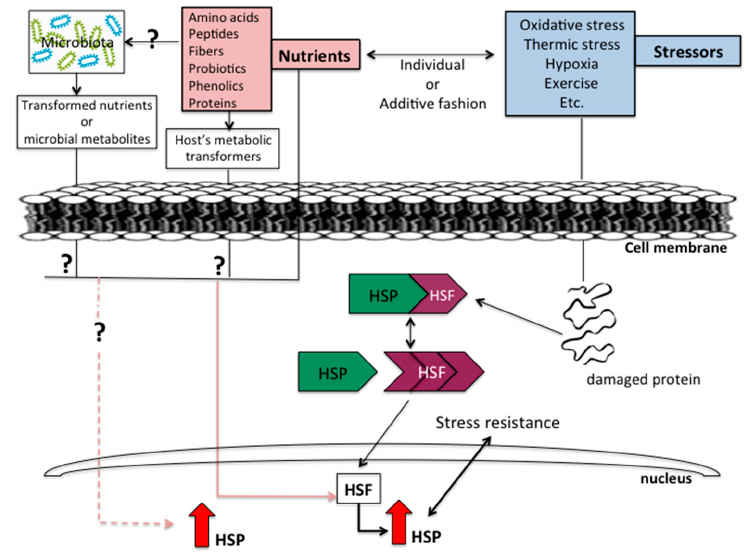
Figure 1. Schematic representation of the role of the classical heat shock-response inducers, now adding nutrients and bioactives. The two kinds of inducers could act individually or in an additive fashion. Explanation: (left side) an ingested nutrient or bioactive could enter directly both the cytoplasm and nucleus as such or be transformed by the microbiota (extracellularly to the host) or by the host’s (intracellularly) own metabolism. On the right-hand side, the classical scheme showing the induction of HSPs that requires the dissociation of the HSP-HSF complex and the participation of HSF in the production of HSP in the